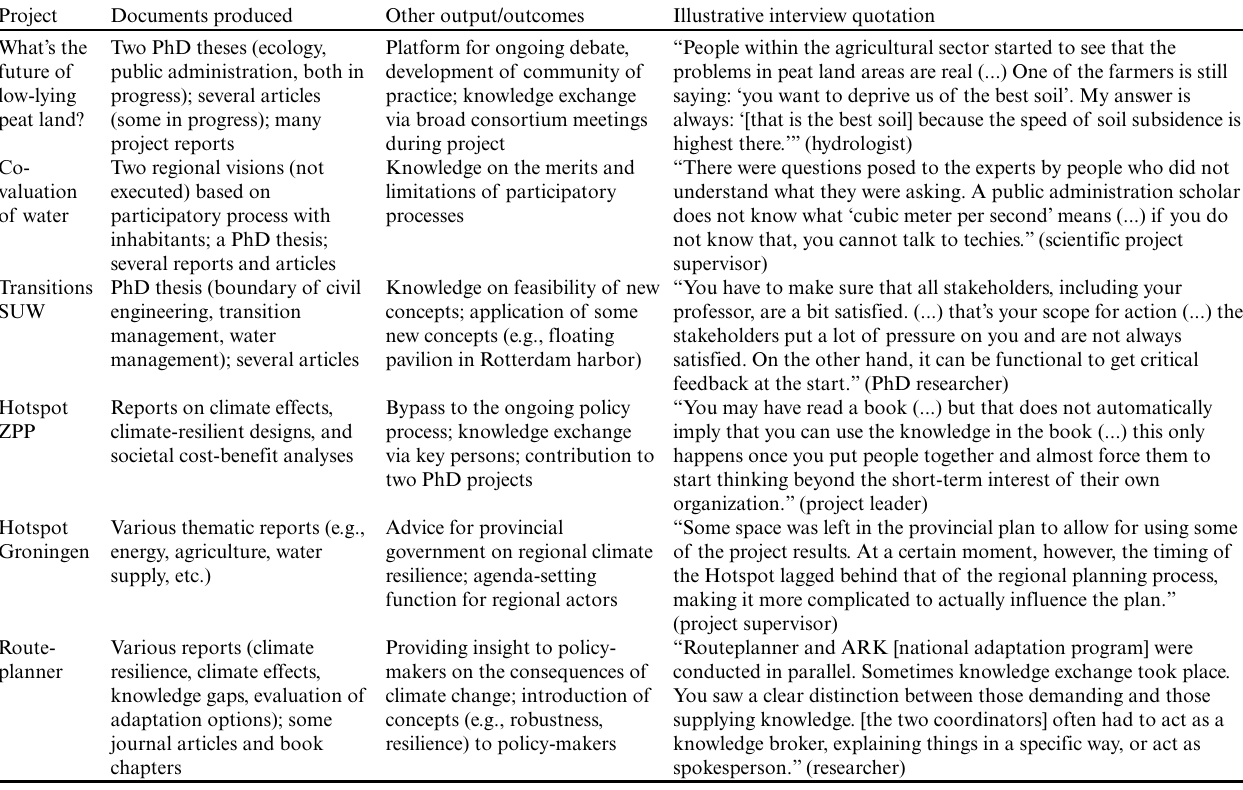
Table 4. Some reported results of the analyzed